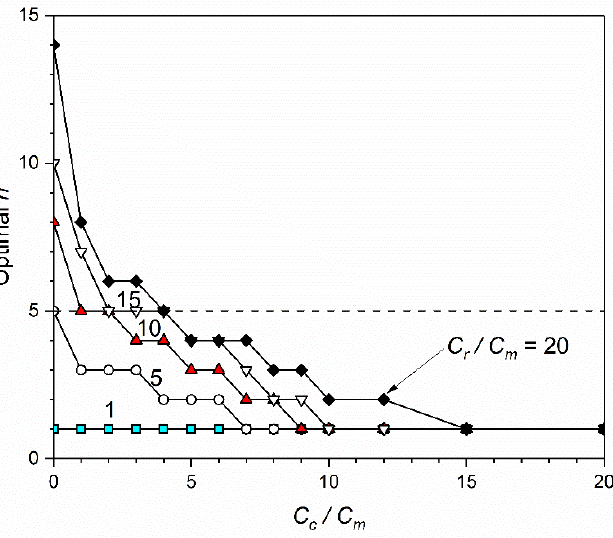
Figure 11. Influences of C c / C m and C r / C m on optimal n value for the example water main.